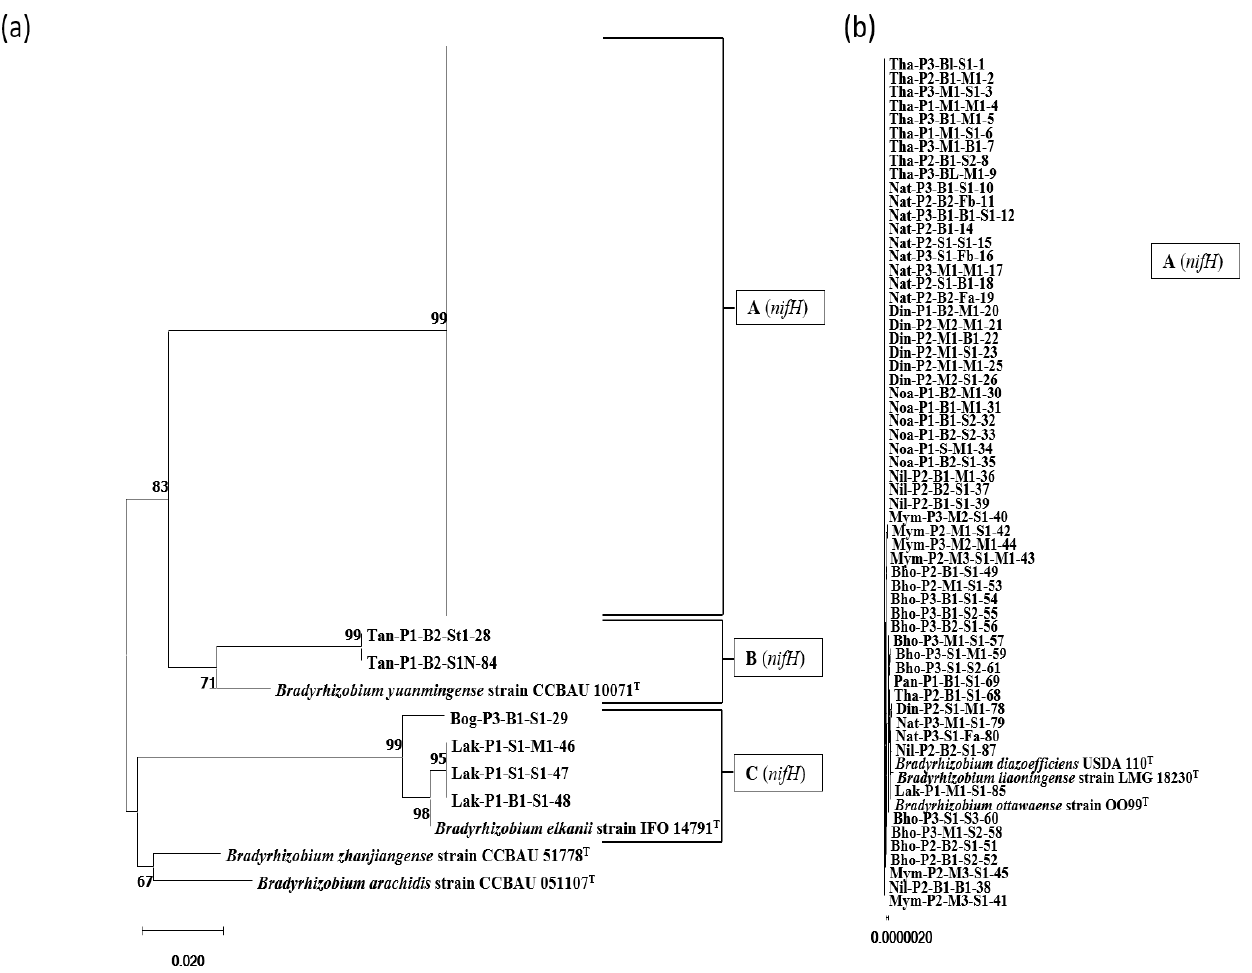
Figure 3. Phylogenetic analysis of the nifH gene of isolated bacteria with reference strain. The percentage of trees in which the associated taxa clustered together after 1000 Bootstrap replications is shown next to the branch points. ( a ) Main tree with one compressed sub-tree has been shown with ( b ) the respective sub-tree.